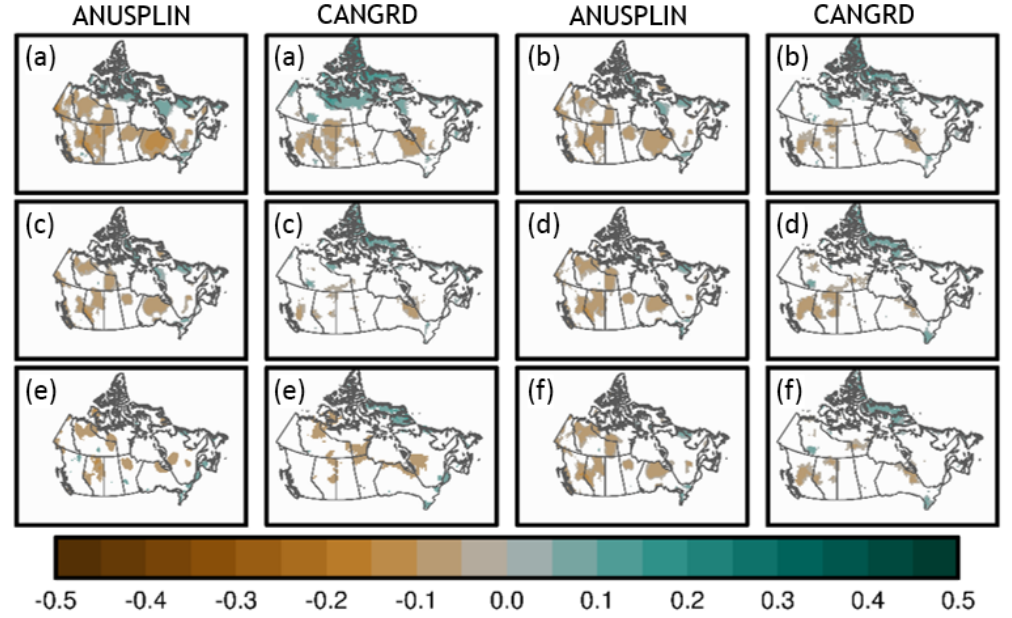
Figure 4. Trends in SPEI at each grid point for ANUSPLIN and CANGRD. Only significant values are shown on the map. Brown indicates decreasing and green is increasing. (a) SPEI at 1 month, (b) SPEI at 3 months, (c) SPEI at 6 months, (d) SPEI at 12 months, (e) SPEI at 6 months from Apr–Sep, and (f) SPEI at 12 months of the water/hydrologic year, i.e. Oct–Sep. Trends are significant at 95% confidence